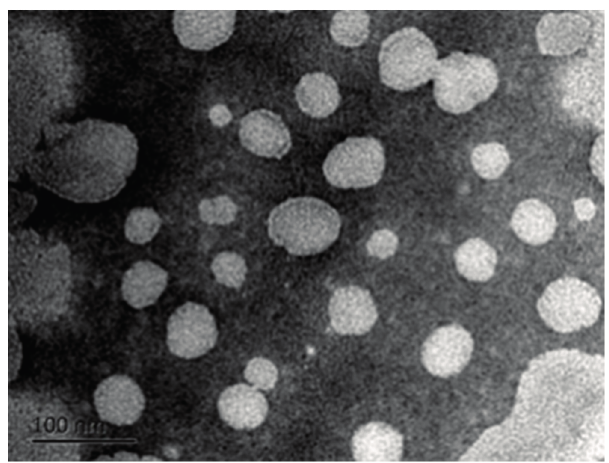
Figure 2. TEM micrograph of curcumin nanoliposomes.